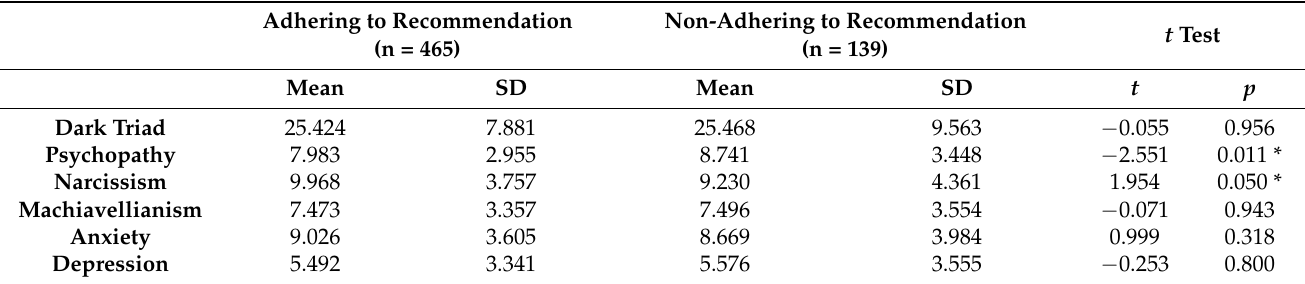
Table 4. Differences between those who reported adherence to hand disinfection recommendations as often as possible and those who did not.